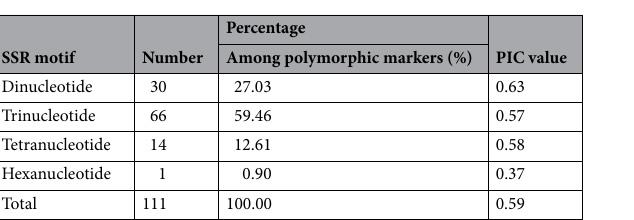
Table 2. Frequencies of different SSR motif types and the PIC values in the polymorphic genic SSR